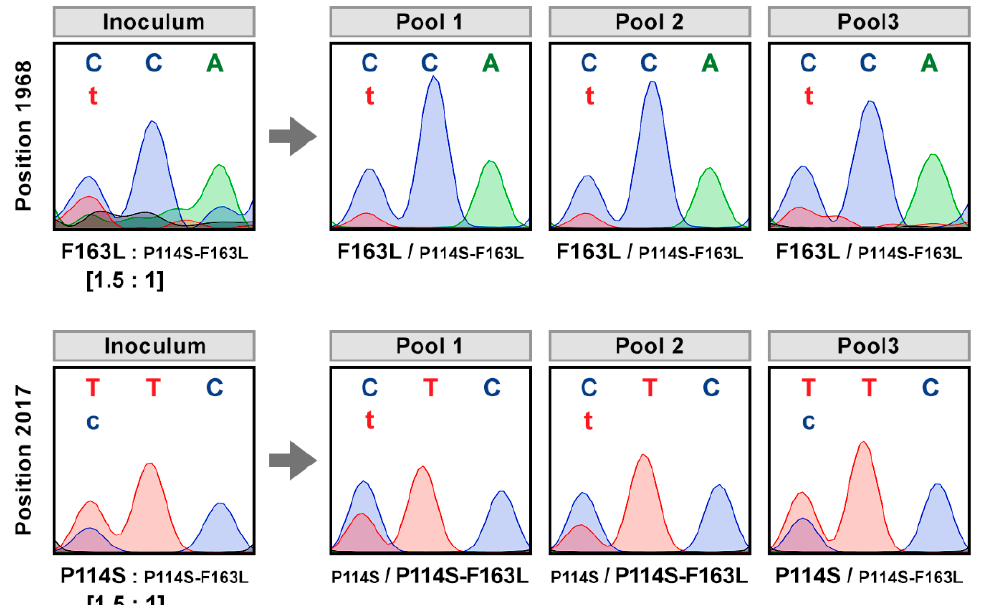
Figure 2. Sequence analysis of viral progeny from Arabidopsis thaliana exposed to mixed infections with competing viruses. DNAs of pICPPV-VPgSwCM-R chimeric clones modified by the specified mutations were mixed at the indicated ratio and biolistically inoculated into six A. thaliana plants. Viral progenies were analyzed in pools of two plants by reverse transcription-polymerase chain reaction (RT-PCR), then sequencing a cDNA fragment covering the VPg coding sequence. Images show the chromatograms of VPg codons 114 (position 1968–1970 in the viral genome) or 163 (position 2017–2019 in the viral genome). Identified viruses are indicated beneath the chromatograms; smaller letters indicate lower accumulation. A similar result was obtained in a replicate assay.